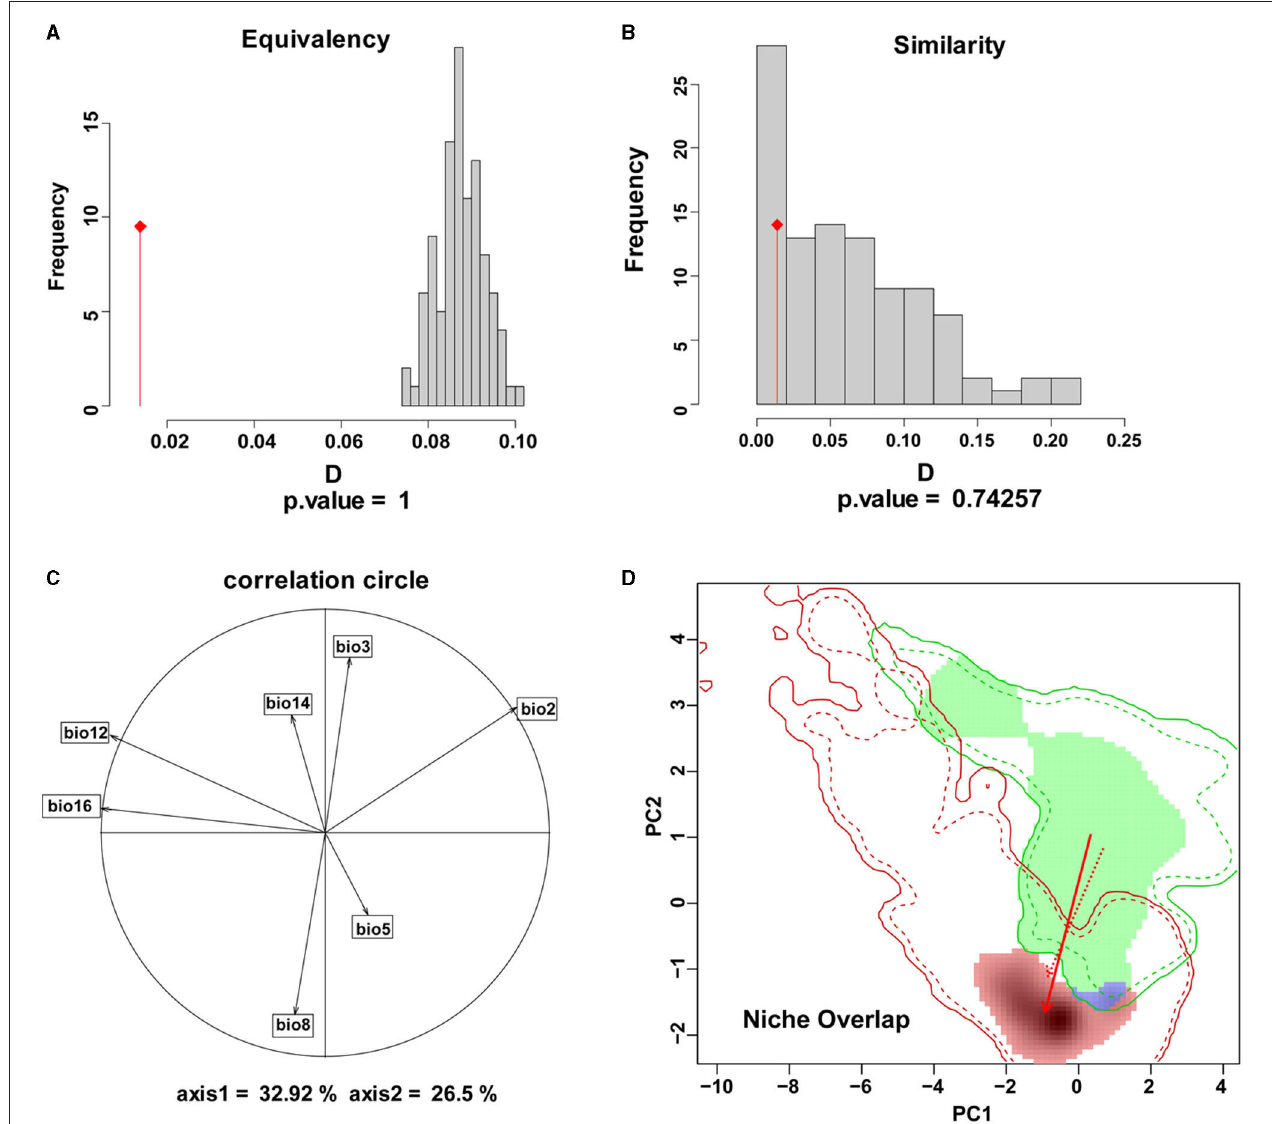
FIGURE 3 | The niches of S. alterniflora in China and America under climatic ecological space. (A) Represents the contribution of each variable to the principal component axis, (B, C) represent the histograms representing the niche equivalence (D) test and niche similarity test of the two regions. (D) Indicates the overlapping of the species origin and invasion countries. Blue indicates niche overlap, green represents unfilling, and red represents